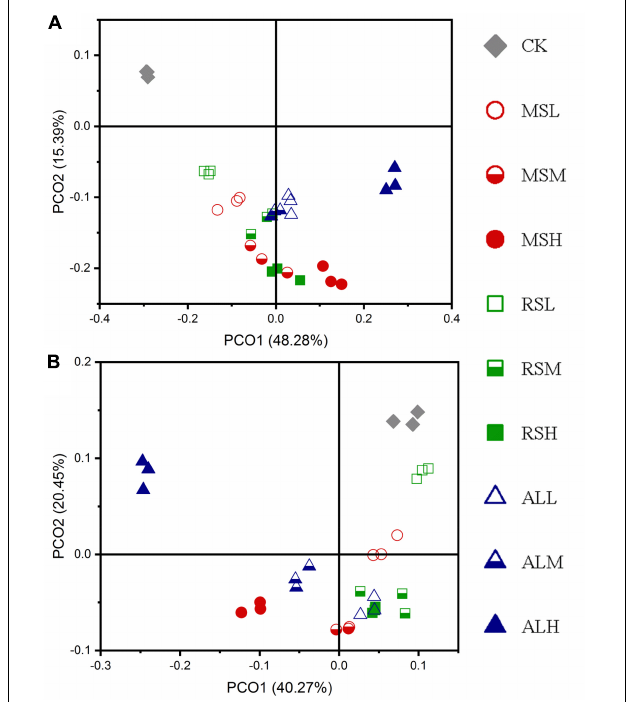
FIGURE 4 | Principal coordinate analysis (PCoA) for the dissimilarity of the bacteria microbial communities in the different soils. (A,B) Day 21 and after tomato planting, respectively. The PCoA of bacterial was based on weighted-unifrac indexes.